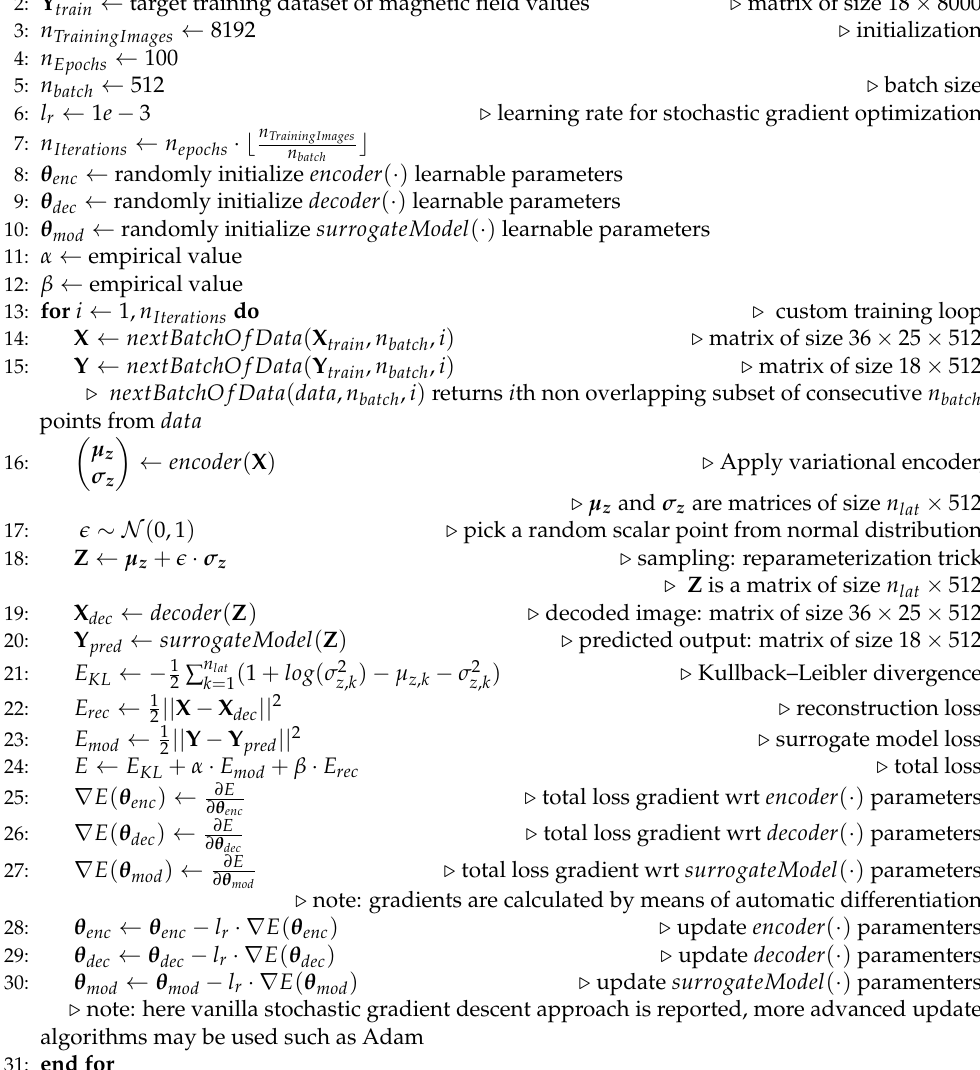
Algorithm 1 Multi-Model Custom Training Loop